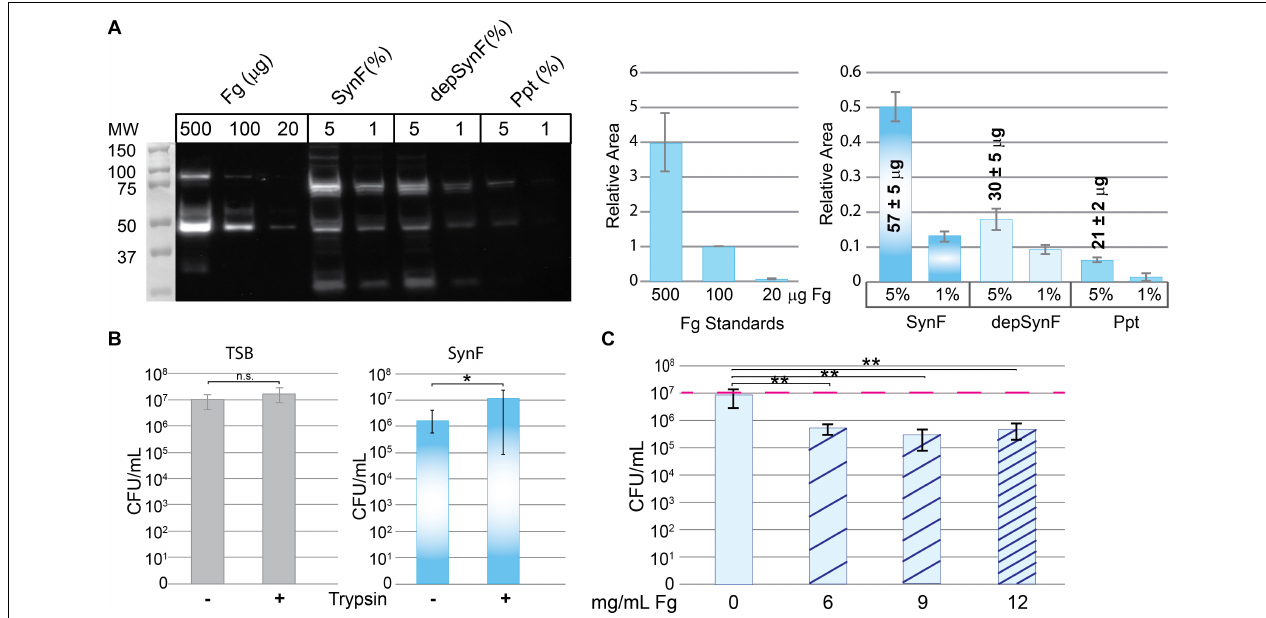
FIGURE 2 | Effects of fibrinogen (Fg) on aggregation. (A) Western blot showing Fg standards, amount of Fg detected in pooled human synovial fluid (equal amounts added; percentage of synovial fluid in solution indicated), and amount remaining in synovial fluid after ethanol depletion of proteins including Fg (depSynF) and amount in the Fg-enriched precipitate (ppt) ( > 3 blots with similar results). Densitometry of this Western blot is shown on the right using varying exposures. Fg standards are plotted in the first graph and used to calculate Fg contained in the 5% samples. Areas associated with the experimental Fg samples were determined and normalized to the 100- µ g sample. (B) Effects of aggregation in pooled synovial fluid on colony-forming units (CFUs)/ml. Minus indicates no dispersion and reflects counts obtained by dilution and counting. Plus indicates the counts after treatment of the cultures with trypsin to disperse aggregates. Values graphed are means ± SD {* p ≤ 0.05; n = 9 [Trypticase Soy Broth (TSB)], 12–13 (Synovial fluid)}. (C) Re-addition of Fg to depSynF causes reacquisition of aggregation at 90 min, as demonstrated by decreased CFU/ml. Red dashed line indicates the initial inoculum. Values graphed are means ± SD (* p ≤ 0.05; ** p ≤ 0.01; n = 6 for each condition; representative experiment of three with similar results for